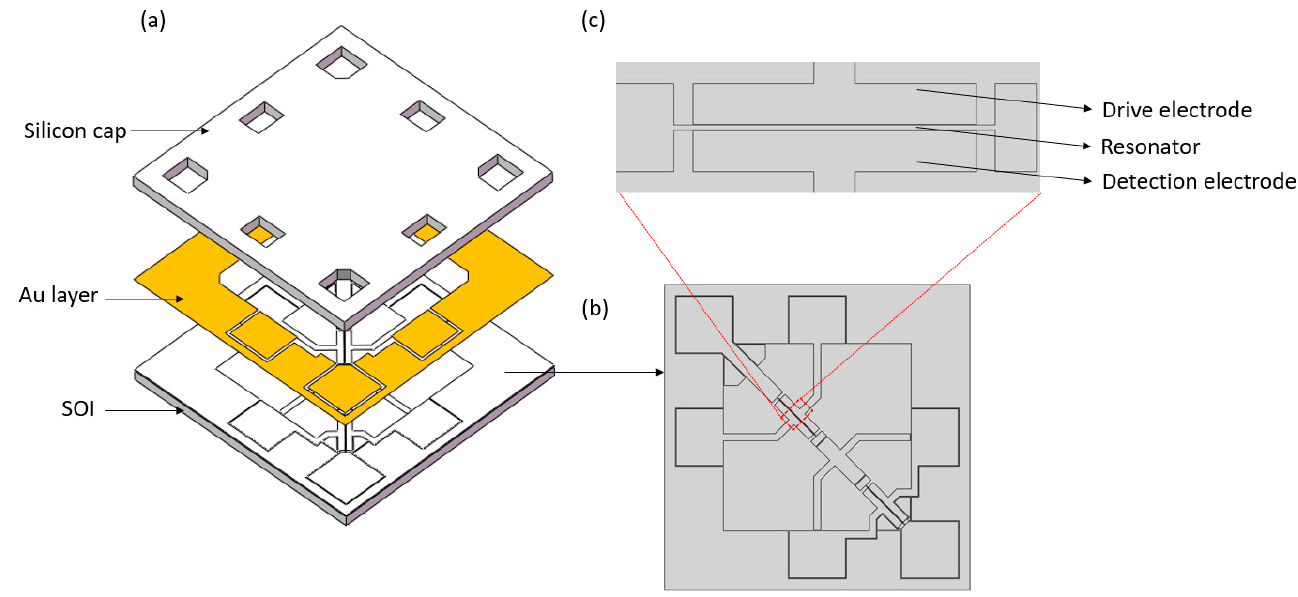
Figure 1. ( a ) Schematic of the resonant pressure microsensor, which consists of an SOI wafer, an Au layer, and a silicon cap. ( b ) The device layer of SOI consists of two resonators, electrodes, and stress balance structures. ( c ) The drive and detection electrodes are located on either side of the resonator.